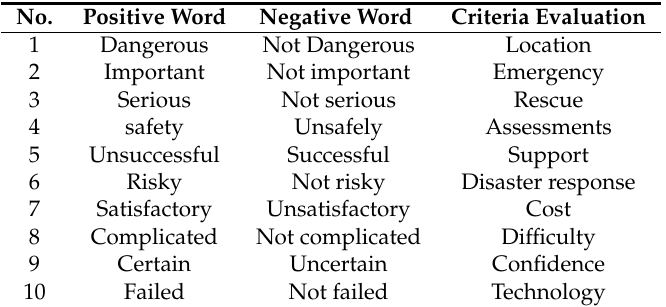
Table 2. Adjectives for Kansei evaluation with its criteria evaluation.